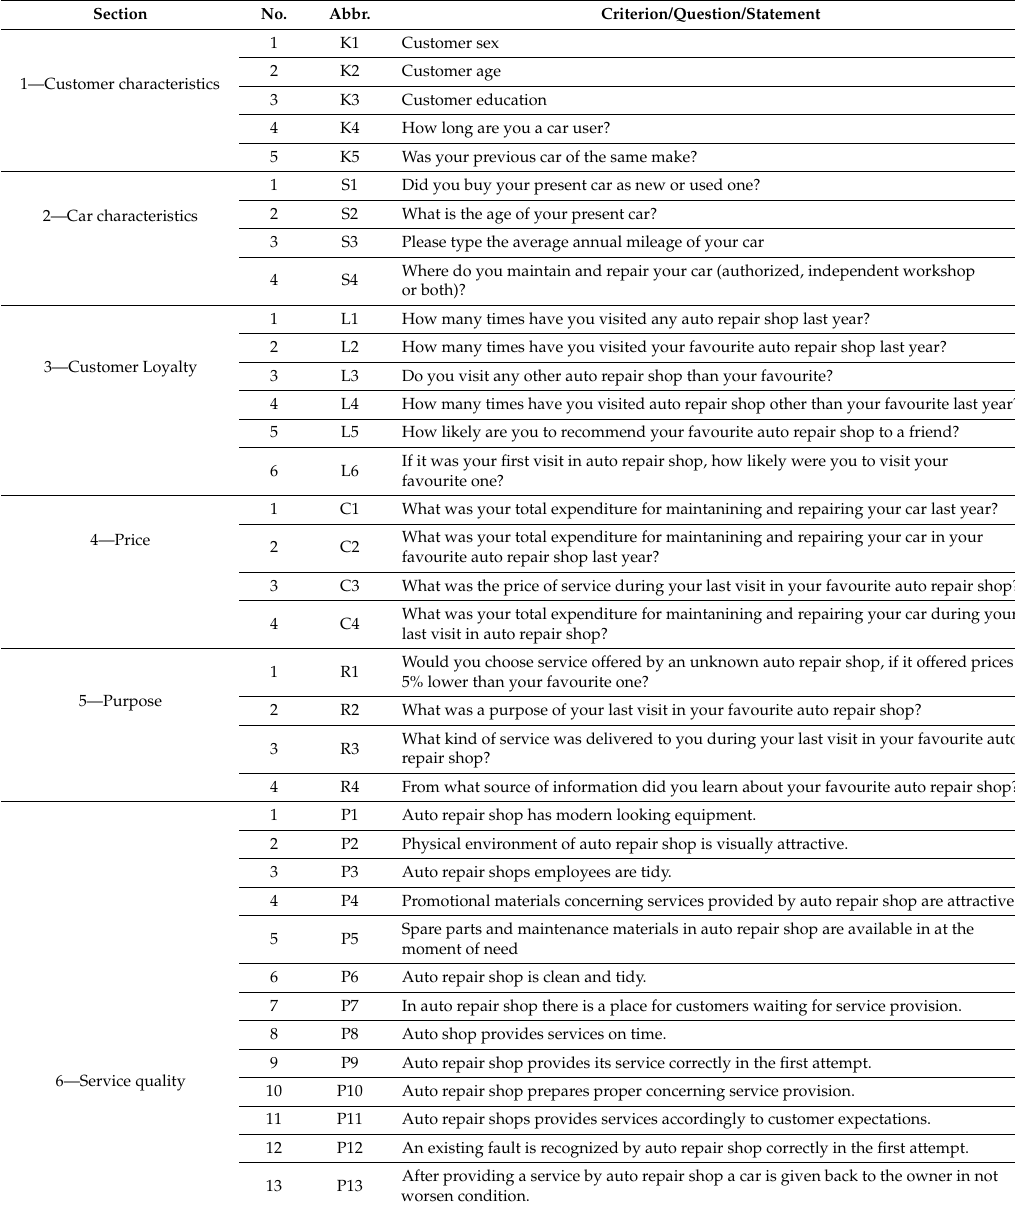
Table A1. Tabular List of